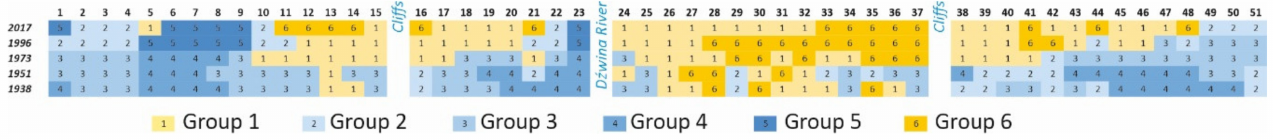
Figure 7. Diagram showing the assignment of all the areas to groups based on Ward’s method.